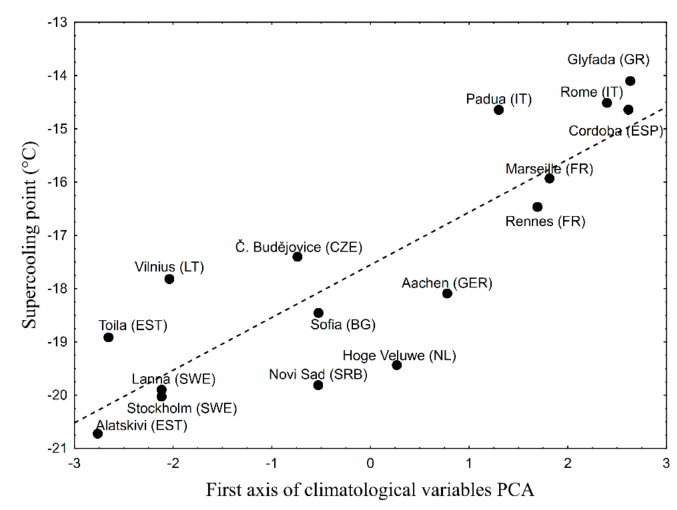
Figure 4. Average population SCP as a linear function of first axis of climatological variables PCA. The correlation is significant and the first PCA axis explained 74% of SCP